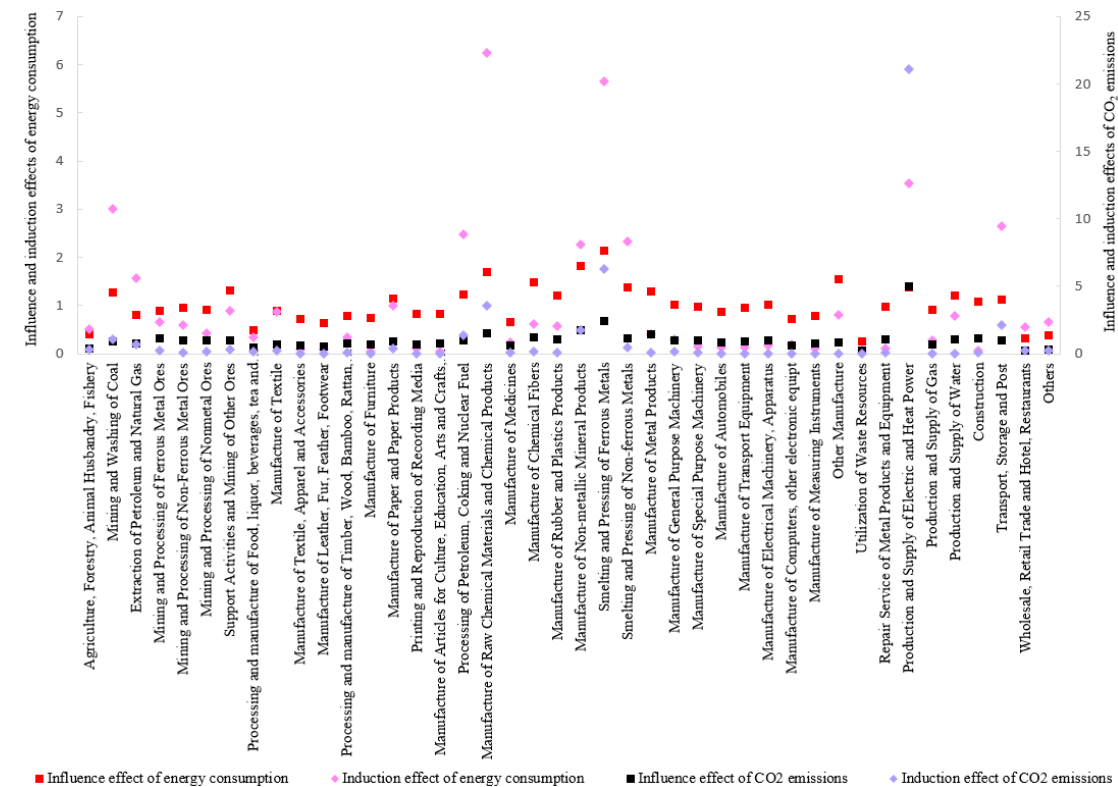
Figure 6. Influence and induction effects of energy consumption and energy-related CO 2 emissions for all 42 economic sectors in China (2012).